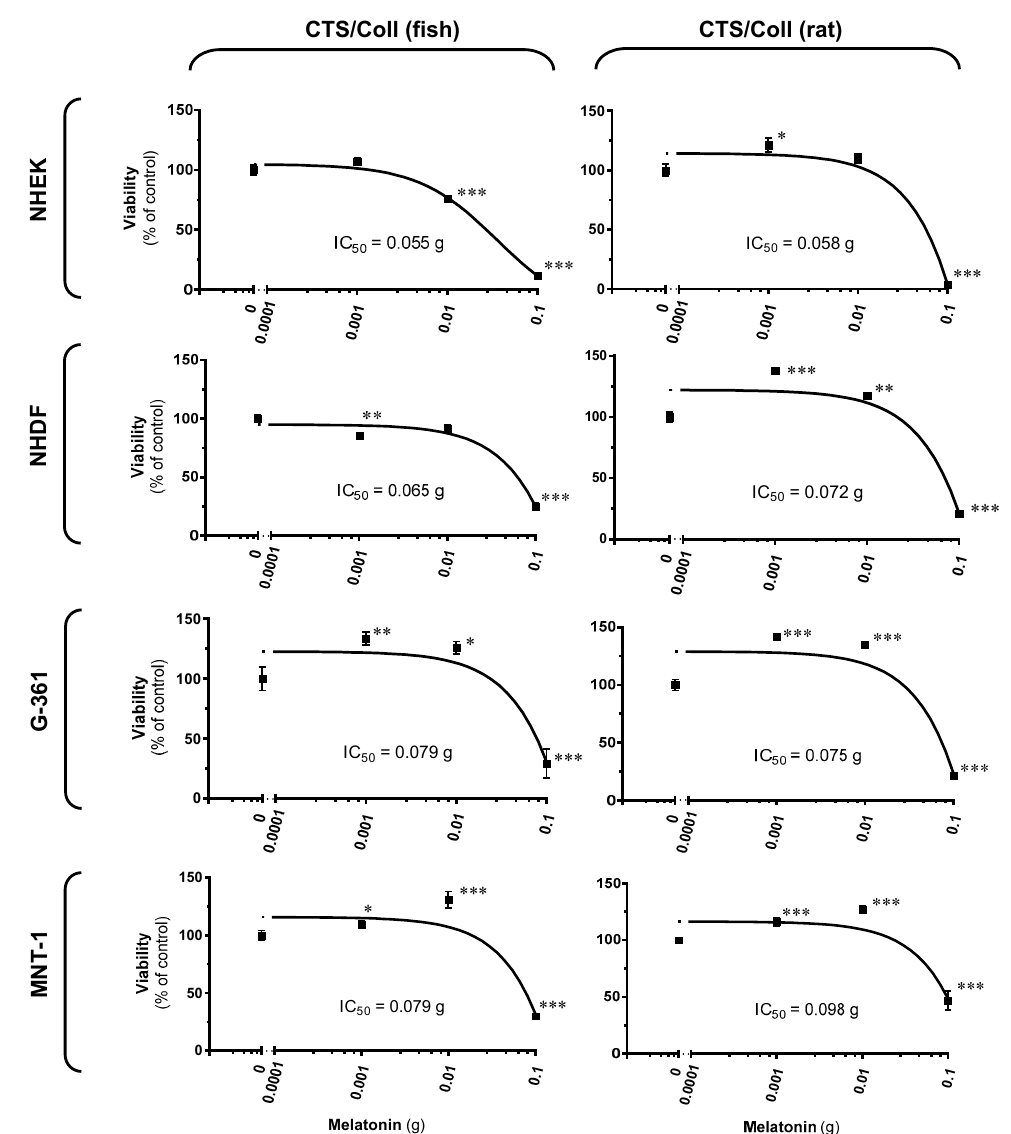
Figure 4. Human epidermal keratinocytes (NHEK), dermal fibroblasts (NHDF), as well as human amelanotic (G-361) and melanotic (MNT-1) melanoma cells, were seeded on CTS/Coll fish- or rat-derived scaffolds containing melatonin in a dose-dependent manner, cultured for 96 h, and viability was assessed using the MTT viability assay as described in Materials and Methods. Data are presented as mean +S.E.M. ( n = 6), expressed as a percentage of the control cells (scaffold without melatonin), and IC 50 values were determined accordingly. Statistically significant differences versus the control were indicated as * p < 0.05, ** p < 0.01, *** p < 0.001.